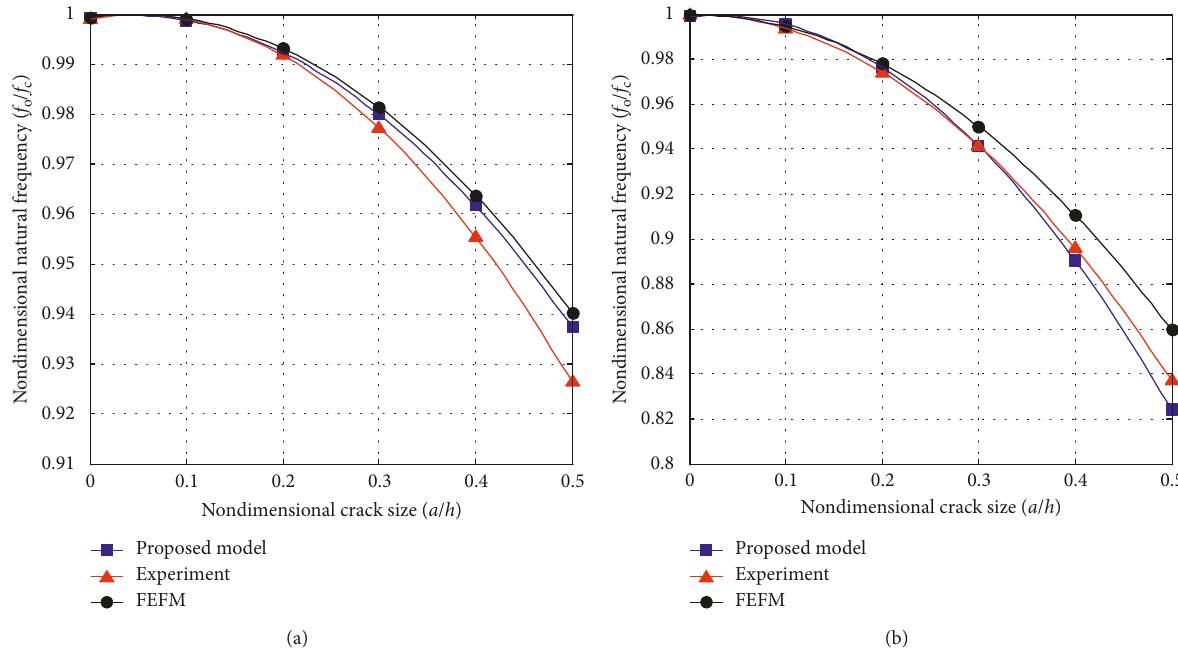
Figure 5: Comparison of the experimental natural frequencies with the FEFM and proposed model results for crack position X � 140mm: (a) the first mode; (b) the second mode.